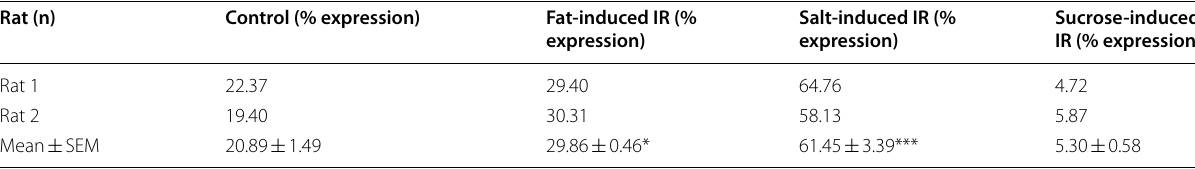
Table 2 FATP/CD36 percentage for individual animals/group